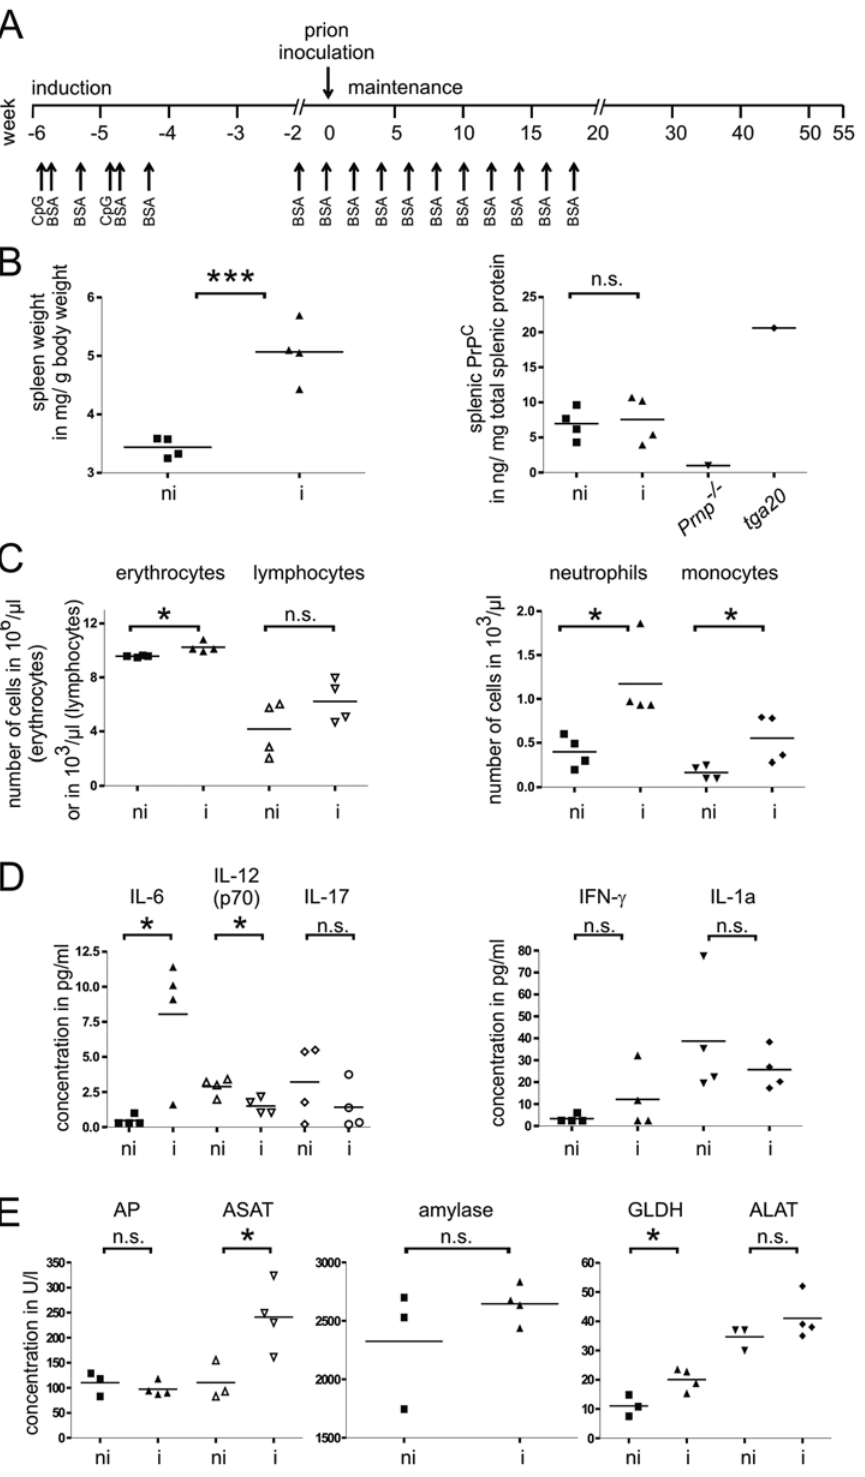
Figure 1. Repetitive immunization of wild-type mice. (A) Treatment scheme for immunization. Arrows denote the time points of injections of CpG oligodeoxynucleotides and bovine serum albumin (BSA). Treatment included an induction ( 2 6 to 2 4 weeks) and a maintenance phase ( 2 2 to + 18 weeks). (B–E) Selected immunized (i) and non- immunized mice (ni) were sacrificed at the time point of prion inoculation. (B) Relative spleen weight and splenic PrP C levels as determined by ELISA. Spleen derived from a PrP C deficient mouse ( Prnp 2 / 2 ) served as negative, spleen from a PrP C overexpressing mouse ( tg a 20 ) as positive control. Hematological cell counts (C) , serum levels of selected cytokines (D) , and blood chemistry (E) (AP: alkaline phosphatase; ASAT: aspartate amino transferase; GLDH: glutamate dehydrogenase; ALAT: alanine amino transferase) showed mild polyglobulia and leukocytosis, as well as mild liver damage in repetitively immunized mice. Unpaired t-tests: (*) p , 0.05; (***) p=0.001; (n.s.) not significantly different.